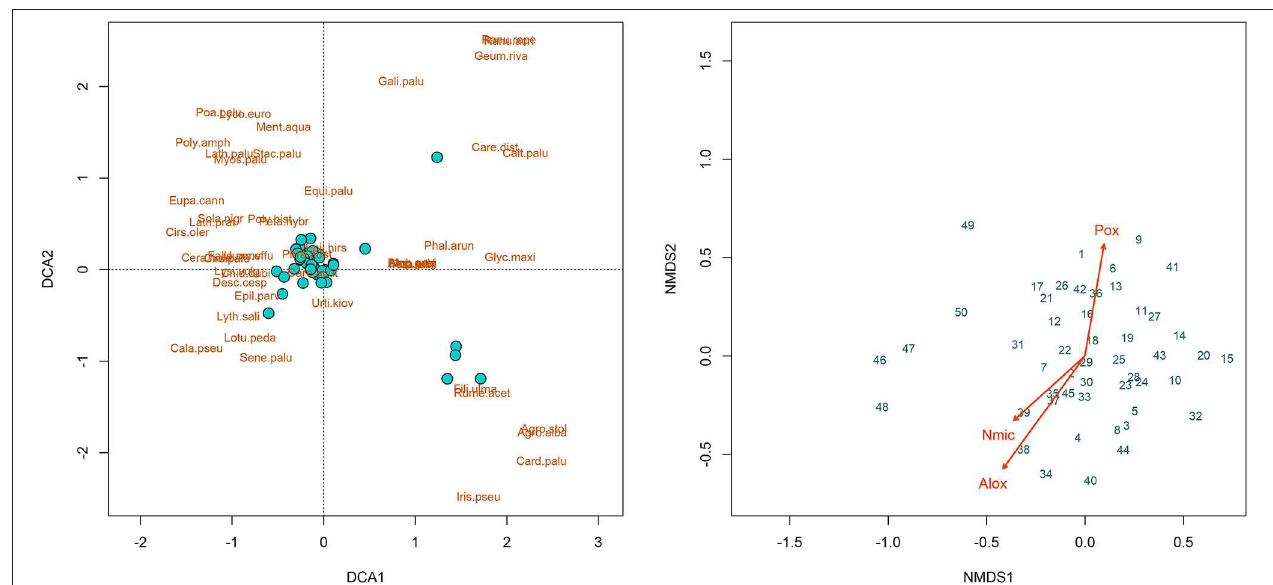
FIGURE 5 | Ordination plots of the detrended correspondence analysis (DCA, left) and of the non-metric multidimensional scaling (NMDS, right), Numbers in the Figure stand for the number of sampling grid cells.